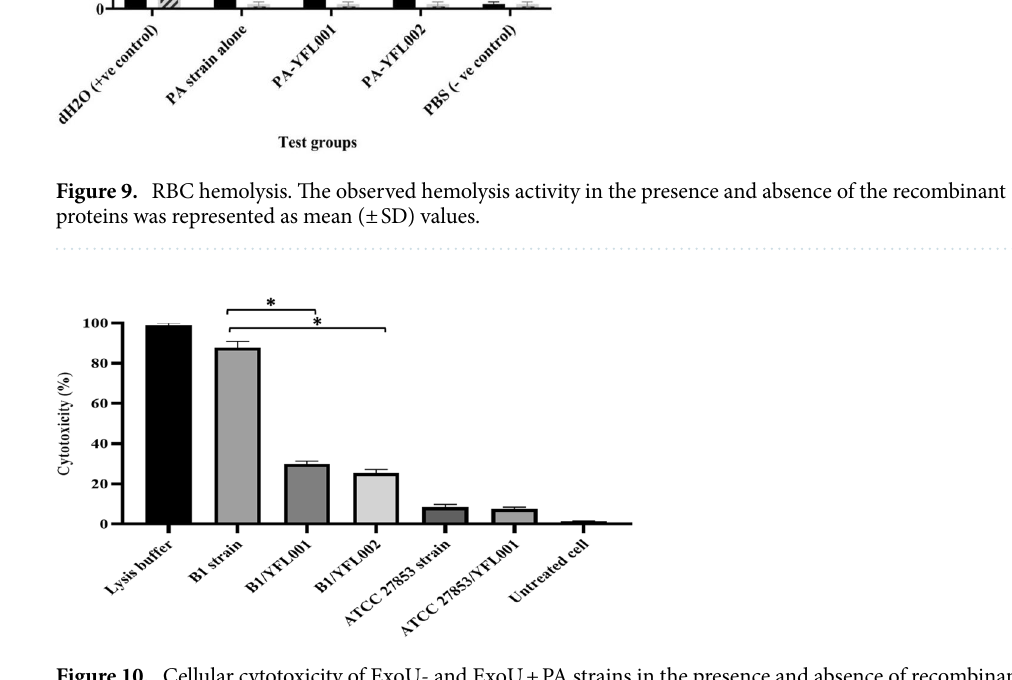
Figure 10. Cellular cytotoxicity of ExoU- and ExoU + PA strains in the presence and absence of recombinant proteins. The observed cellular cytotoxicity was represented as mean (± SD) values. P values less than 0.05 were designated with